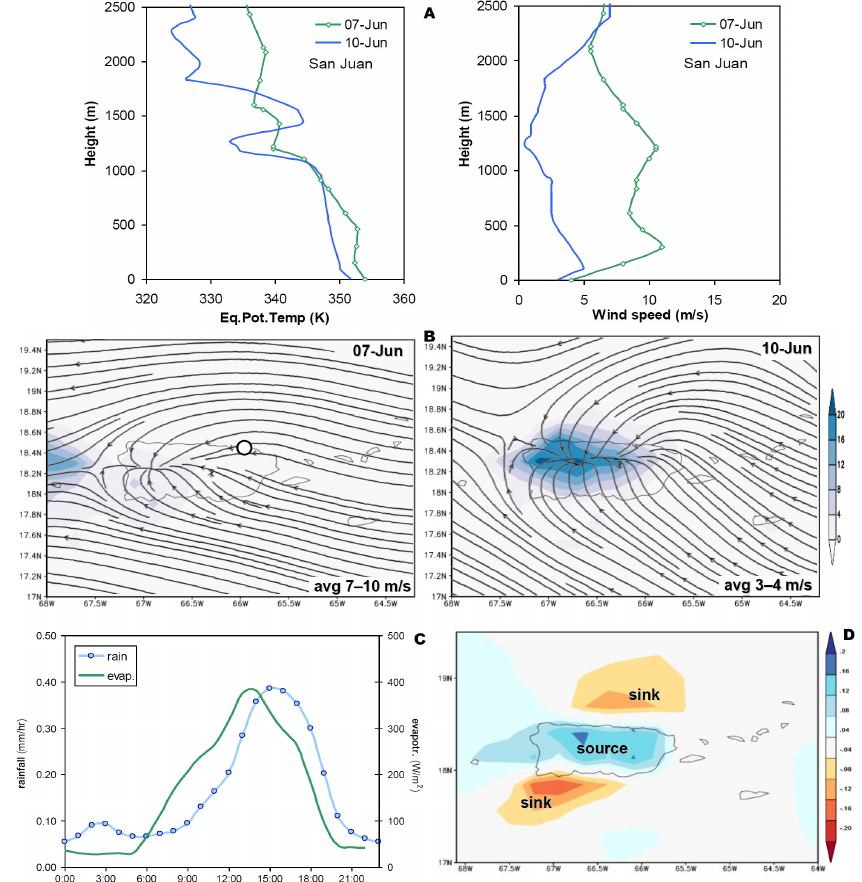
Figure 7. Strong vs weak trade wind case study: ( a ) San Juan radiosonde profiles (at dot in b) comparing equivalent potential temperature (left) and wind speed (right). ( b ) Operational wind streamlines at 2 pm and daily GPM rainfall (mm) for 7 June (left) and 10 June (right). ( c ) Mean diurnal cycle of rainfall and evapotranspiration over the island. ( d ) 1979–2019 regression of annual land minus sea rainfall onto ECMWF5 evaporation, positive